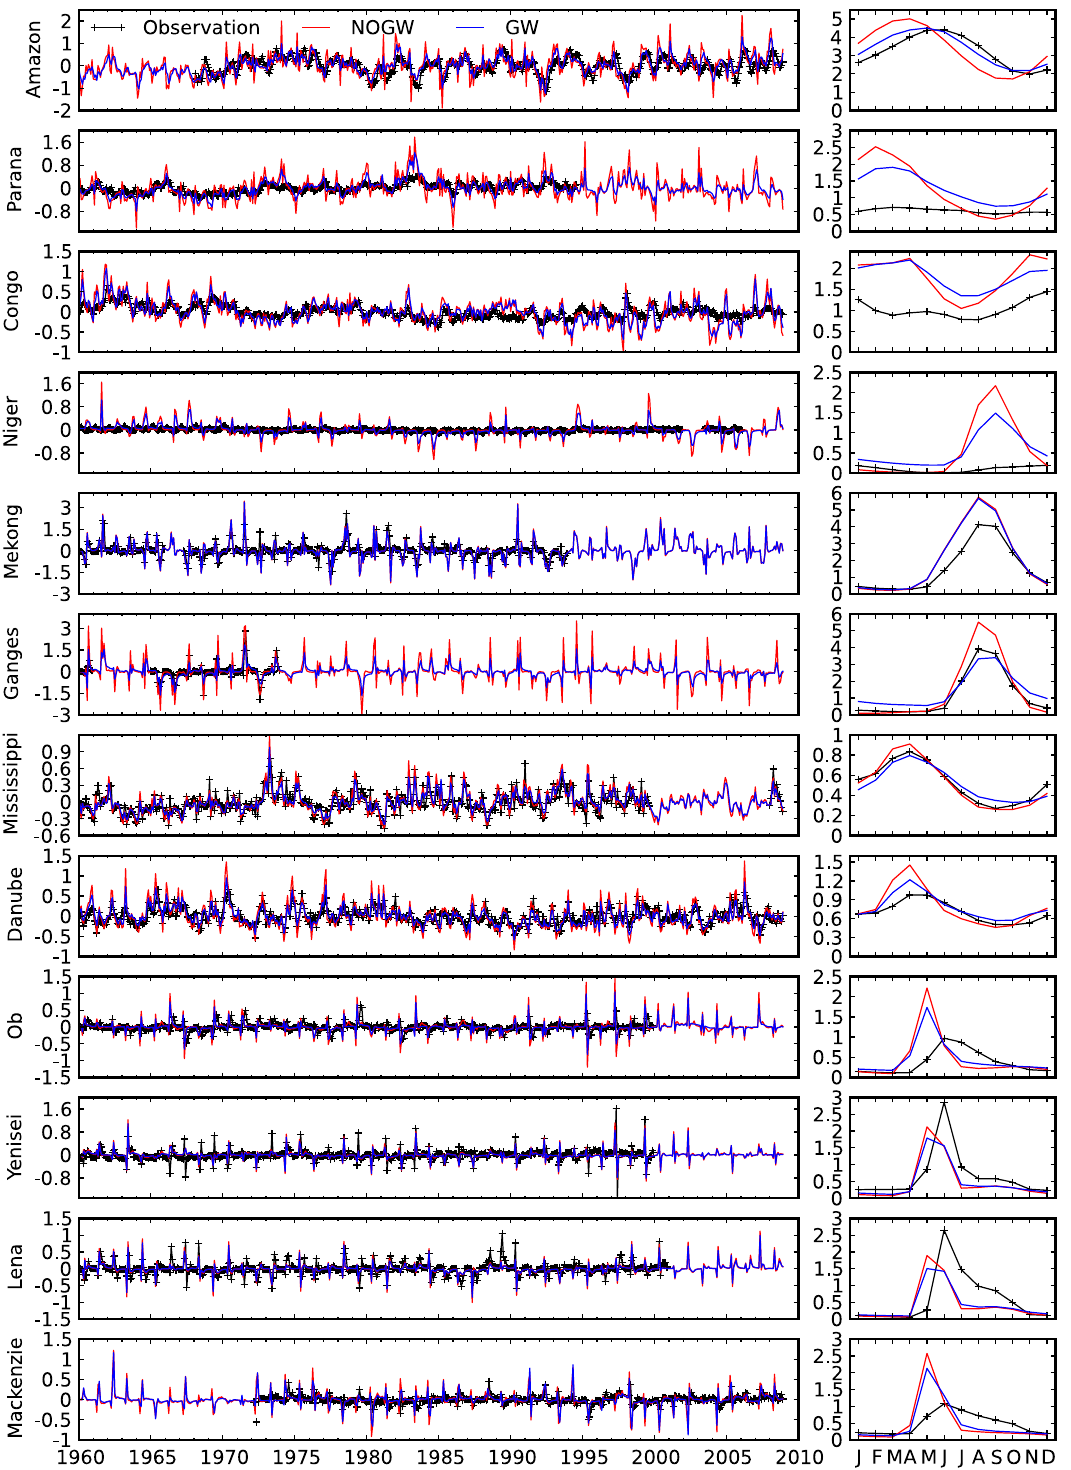
Fig. 5. Basin-scale comparison (mmday − 1 ) between the (right) annual cycle and (left) monthly mean anomalies of simulated and observed discharges. Statistics for each station are shown in Table